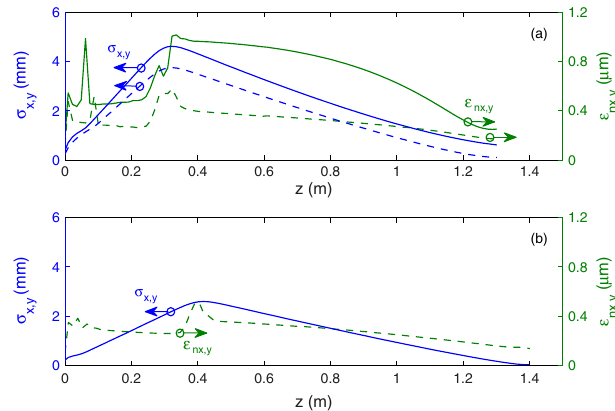
FIG. 14. Beam envelopes and emittance in the shortened beam line for (a) dc and (b) SRF guns. The dc gun shows two cases: 10 ps (solid) and 30 ps (dashed line) rms initial laser pulse. The photocathode MTE is 120